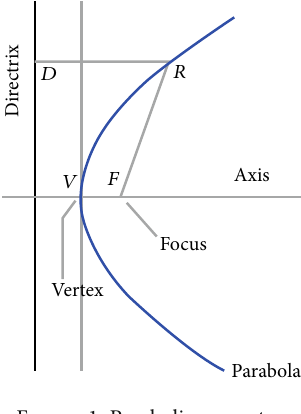
Figure 1: Parabolic